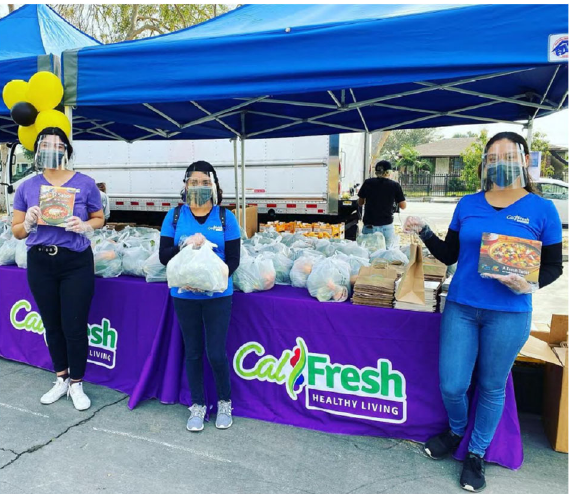
Figure 1. Health educators participating in an event providing bilingual cookbooks, recipe cards, and informational nutrition handouts to accompany fresh produce distribution.